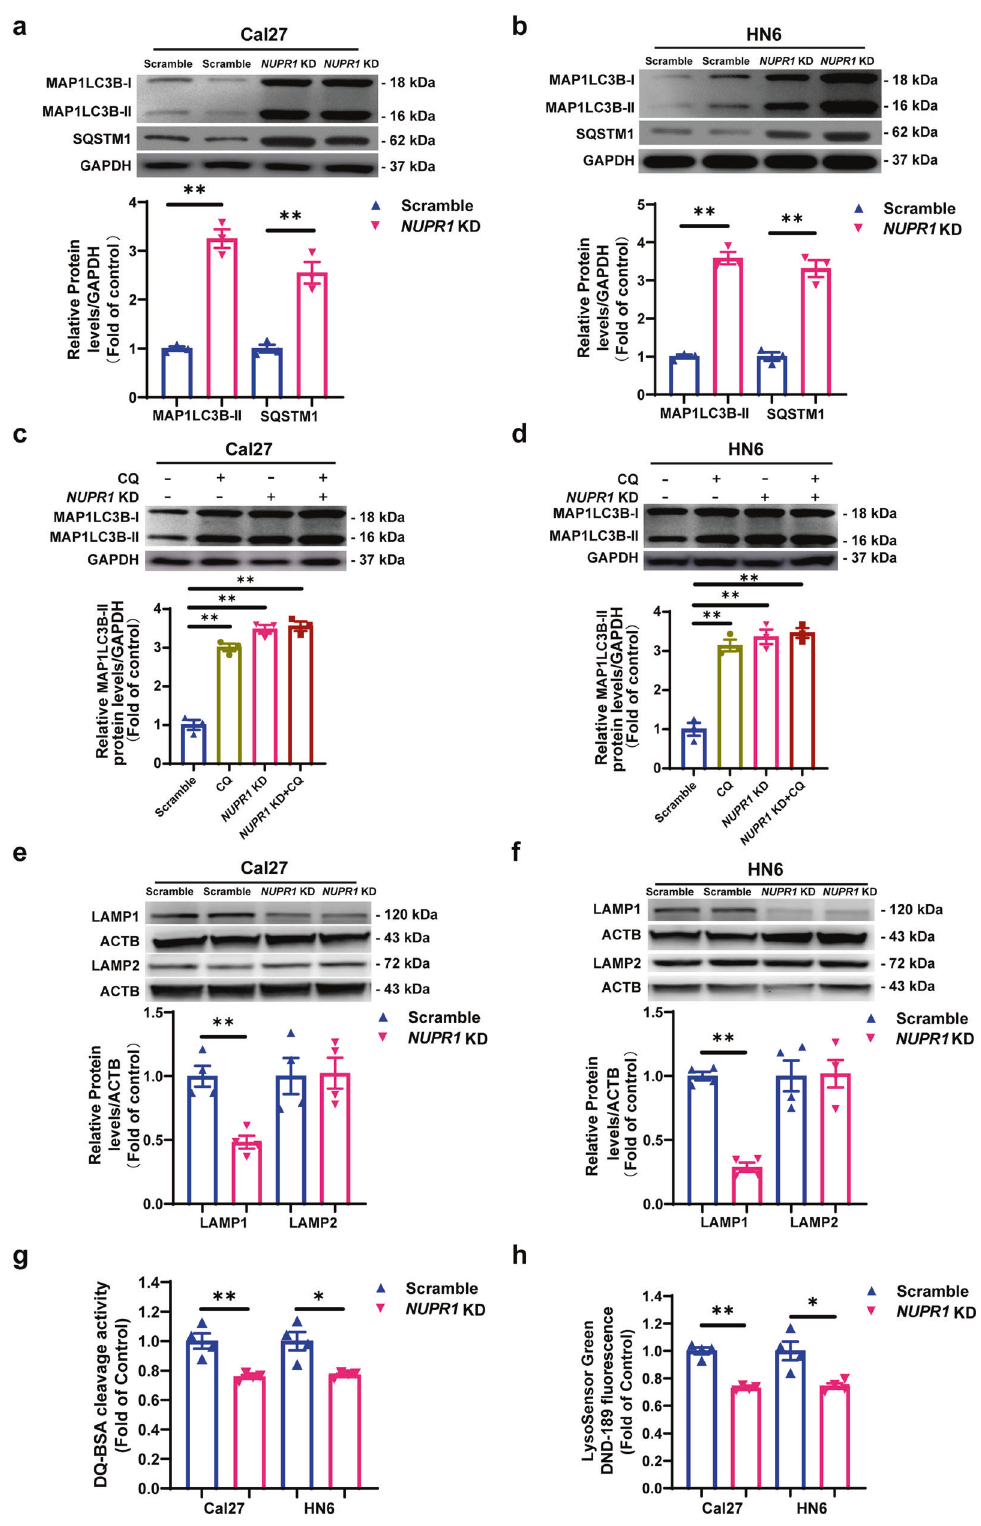
Fig. 2 NUPR1 KD restrained autophagic fl ux and lysosomal function in OSCC cells. a , b Immunoblotting analysis of MAP1LC3B-II and SQSTM1 levels in NUPR1 KD or scrambled Cal27 and HN6 cells; n = 3. c , d Immunoblotting analysis of MAP1LC3B-II in NUPR1 KD or scrambled Cal27 and HN6 cells in the absence or presence of CQ (10 μ M) for 24 h; n = 3. e , f Immunoblotting analysis of LAMP1 and LAMP2 in NUPR1 KD or scrambled Cal27 and HN6 cells; n = 4. g DQ-BSA staining fl uorescence intensity in NUPR1 KD or scrambled Cal27 and HN6 cells; n = 4. h LysoSensor DND-189 fl uorescence intensity in NUPR1 KD or scrambled Cal27 and HN6 cells. n = 4; * P < 0.05, ** P < 0.01 vs. the scrambled